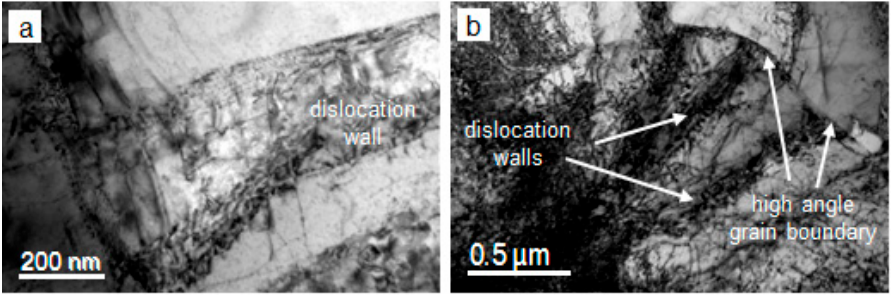
Figure 11. Dislocation walls in ( a ) Ti ‐ steel and ( b ) MoNbTi ‐ steel.